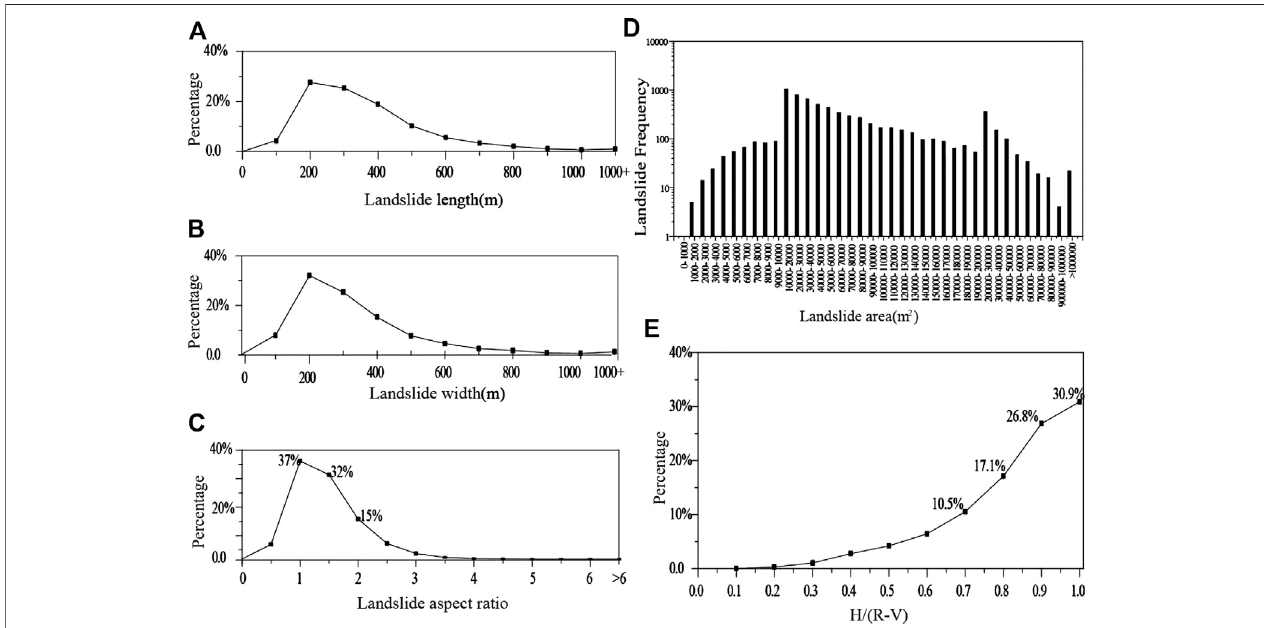
FIGURE 5 | Landslide parameter statistics. (A) , statistics on the relationship between landslide length and frequency; (B) , statistics on the relationship between landslide width and frequency; (C) , statistics on the relationship between landslide aspect ratio and frequency; (D) , statistics on the relationship between landslide area and Frequency; (E) , statistics on the relationship between landslide H/(R − V) and frequency.